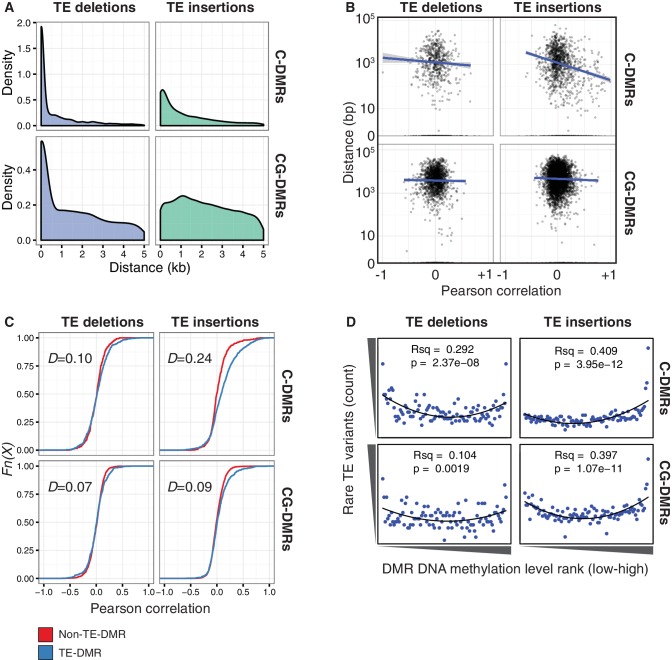
TE variants are associated with nearby DMR methylation levels.(A) Distribution of distances from TE variants to the nearest population DMR, for TE deletions and TE insertions, C-DMRs and CG-DMRs. (B) Pearson correlation between DMR DNA methylation level and TE presence/absence, for all DMRs and their closest TE variant, versus the distance from the DMR to the TE variant (log scale). Blue lines show a linear regression between the correlation coefficients and the log10 distance to the TE variant. (C) Empirical cumulative distribution of Pearson correlation coefficients between TE presence/absence and DMR methylation level for TE insertions, TE deletions, C-DMRs and CG-DMRs. The Kolmogorov–Smirnov statistic is shown in each plot, indicated by D. (D) Relationship between rare TE variant counts and nearby DMR DNA methylation level ranks, for TE insertions, deletions, C-DMRs, and CG-DMRs. Plot shows the cumulative number of rare TE variants in equal-sized bins of DMR methylation level ranks, from the lowest ranked accession (left) to the highest ranked accession (right). Lines indicate the fit of a quadratic model, and the corresponding R2 and p values are shown in each plot.